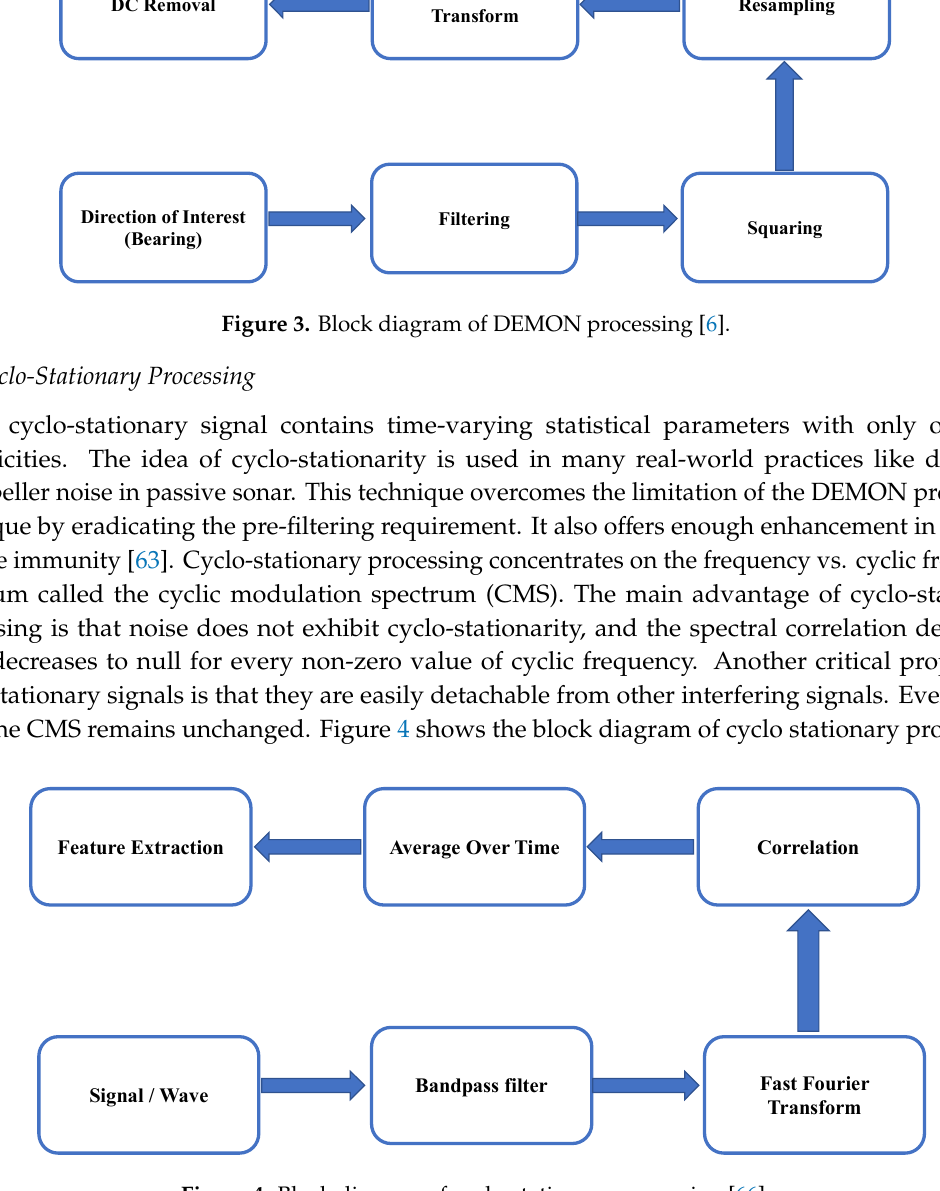
Figure 4. Block diagram of cyclo-stationary processing [66].